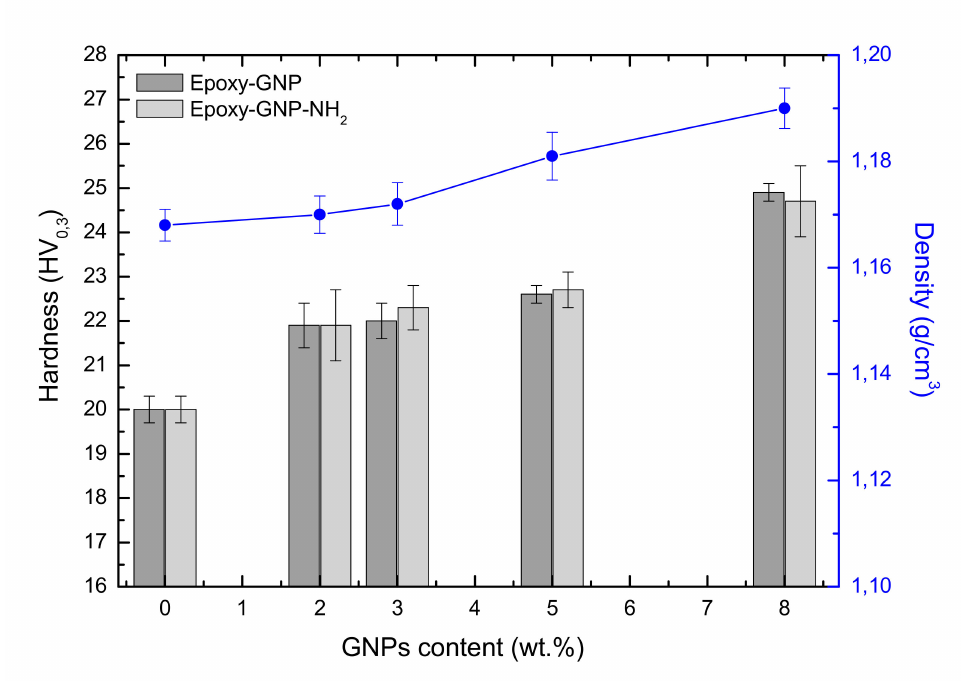
Figure 3. Variation of microhardness (columns) and density (blue circles) of epoxy / GNPs nanocomposites as a function of GNPs